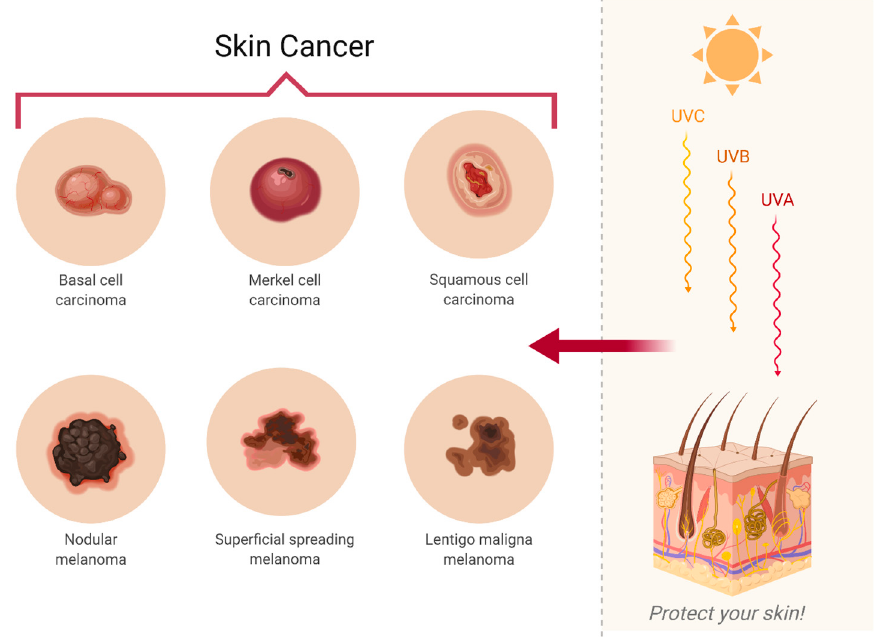
Figure 3. Skin cancer issues caused by unprotected skin health. The figure was created with “BioRender.com” template and exported under the terms of premium